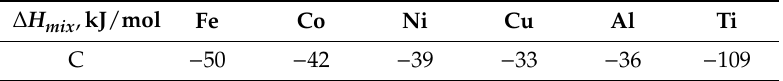
Table 1. The mixing enthalpy of di ff erent atomic pairs [34].